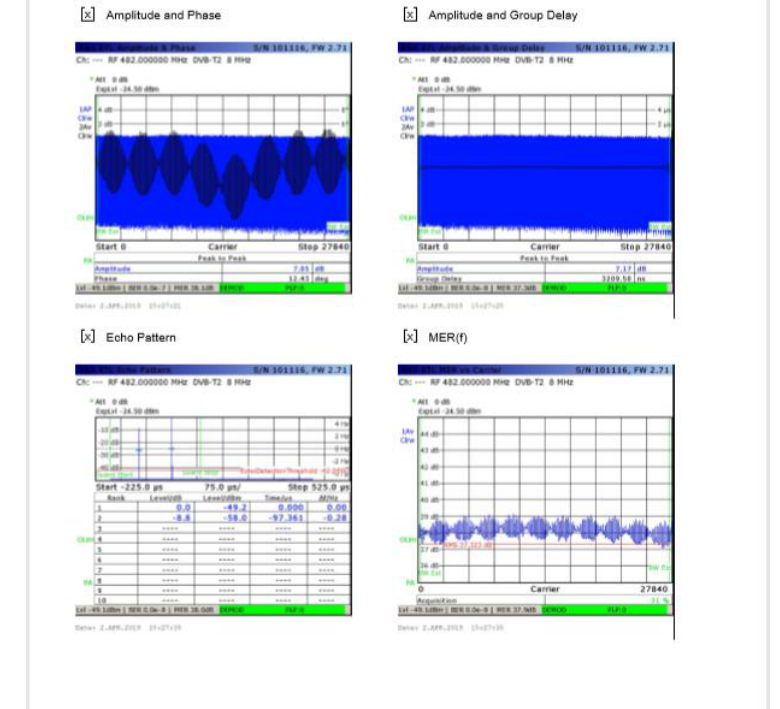
Figure 18. DVB-T2 Signal Form and Values parameters measured in the SFN mode: Level -49.2 dBm; Δ Level, -8.8 dB Amplitude 7.15 dB; Phase 12.56 deg; MER(f); MER (PLP, rms) 38.0 dB; Time offset 100 μs